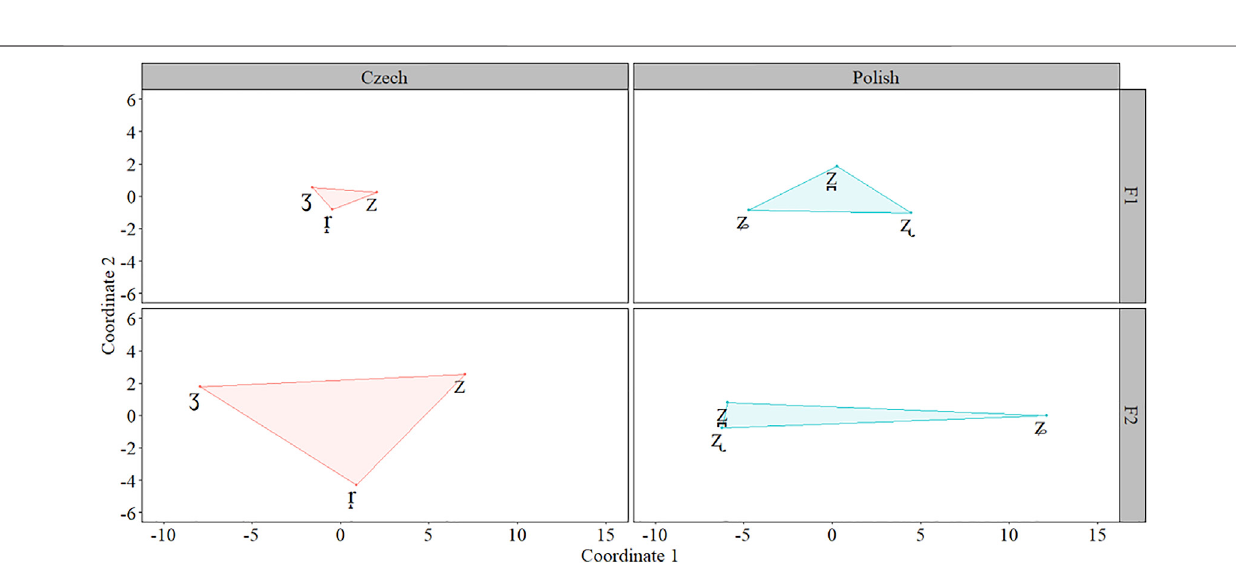
Frontiers in Communication |